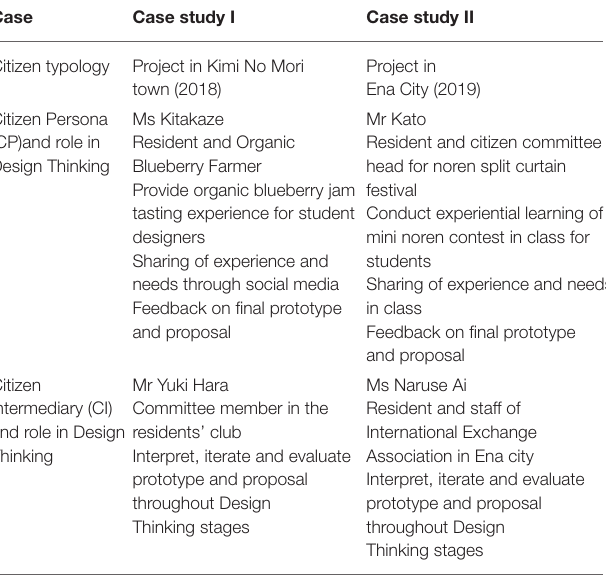
TABLE 1 | Samples of citizen science